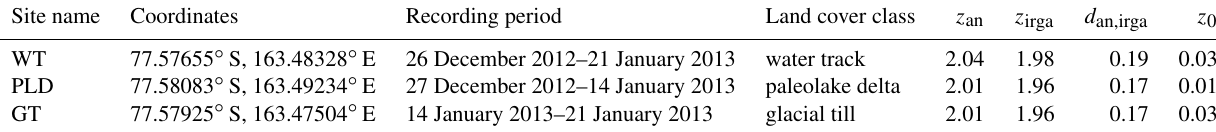
Table 1. Installation notes for the three eddy-covariance stations, with height of anemometer z an , height of infrared gas analyzer z irga , horizontal distance between both devices d an,irga , and estimated roughness length z 0 ; all lengths in meters. PLD and GT are non-water track reference surfaces, and were summarized as NWT.